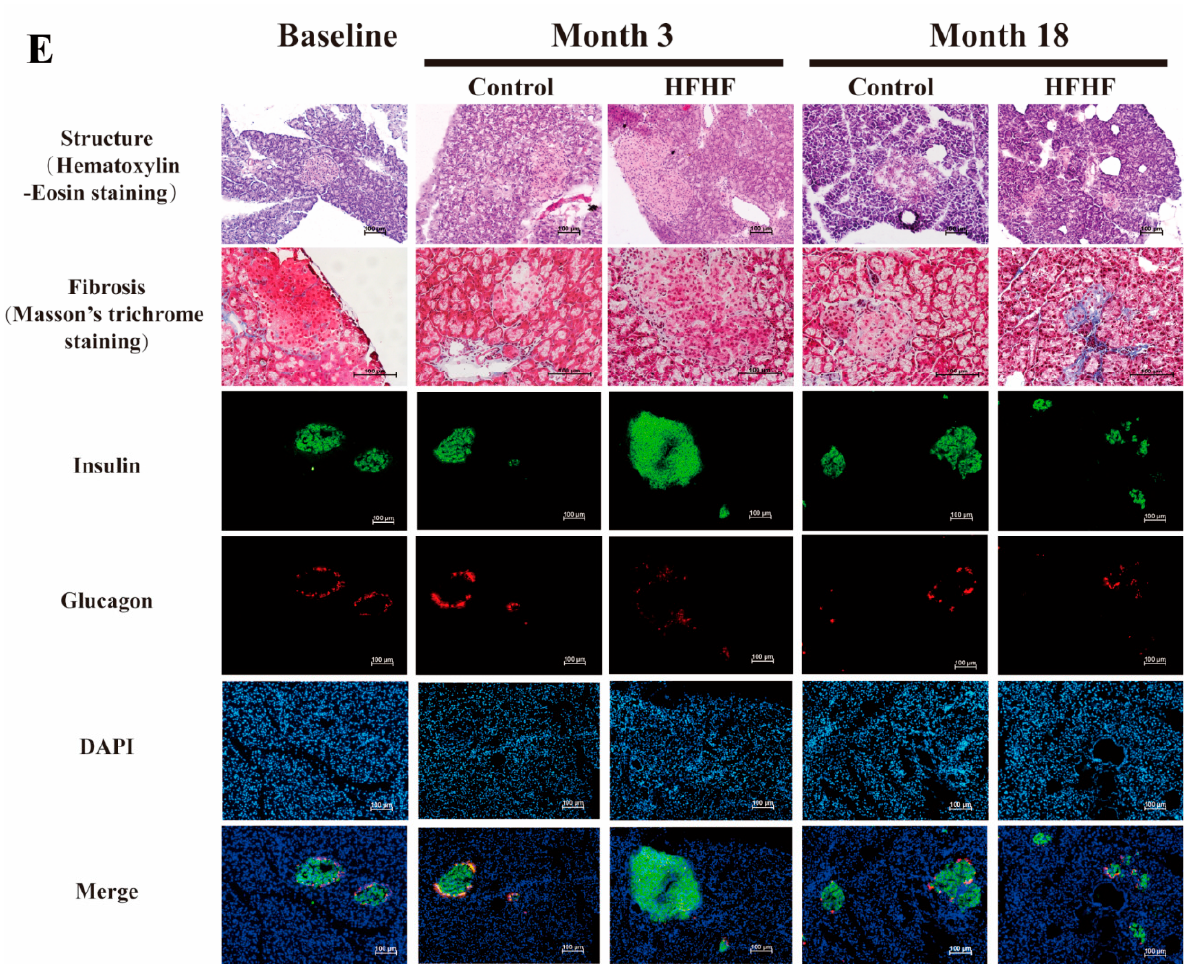
Figure 3. Structural and function changes of the pancreas in this study. ( A – D ) Fasting plasmatic insulin, C-peptide, proinsulin, and intact proinsulin levels during the study for the normal diet (control, blue) and high-fat, high-fructose diet (HFHF, red) groups at the beginning (baseline) and after 3 (month 3) and 18 (month 3) months of feeding. Results are shown as the mean ± SD. * Significant results versus the age-matched control group: * p < 0.05, ** p < 0.01, *** p < 0.001, **** p < 0.0001. ( E ) Changes in islets were visualized using hematoxylin/eosin staining, Masson’s Trichrome staining, and insulin and glucagon immunofluorescence staining at the beginning (baseline) and after 3 (month 3) and 18 (month 18) months of normal (control) and high-fat, high-fructose (HFHF) diet feeding. Scale bar = 100 µ